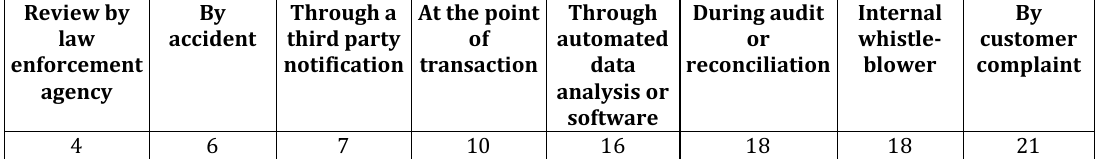
Table 11: Response about How Fraud incident is Typically Detected in Bank Review by